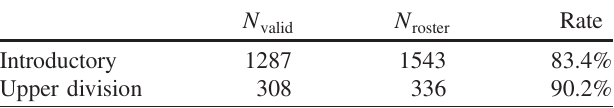
TABLE I. Overall participation rates for the introductory and upper-division populations. Participation rates (Rate) represent the percentage of the total course enrollment for which we collected valid responses ( N ) in the final dataset. Individual valid course participation rates varied from 70% to